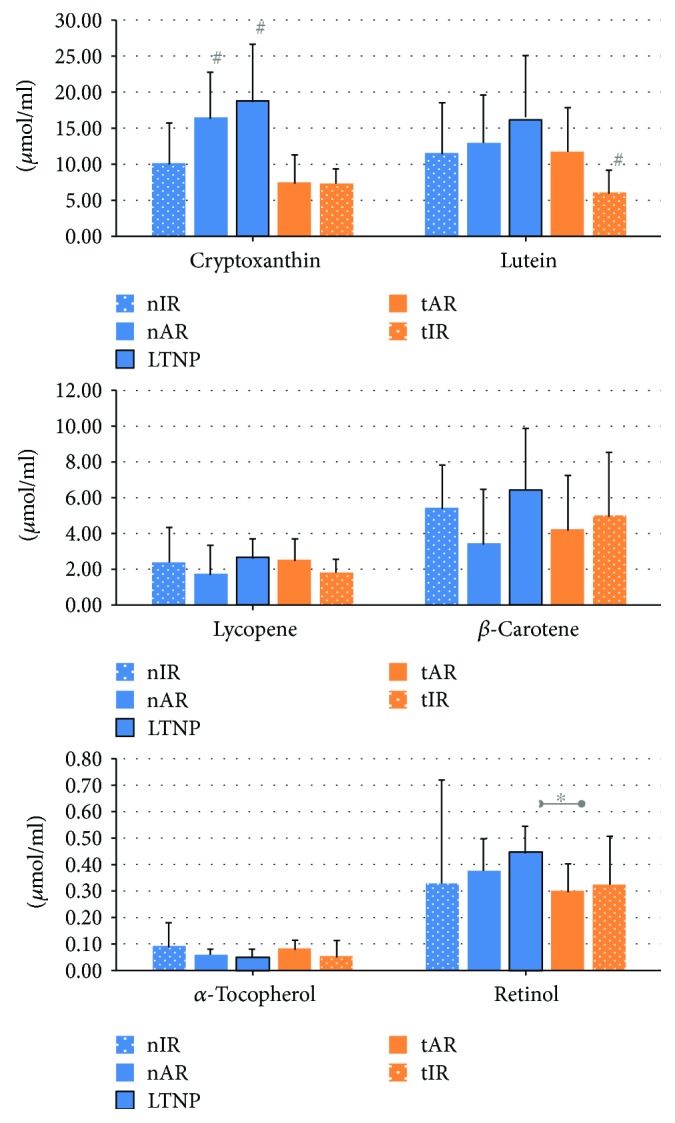
Plasma levels of carotenoids, retinol, and α-tocopherol of the 92 people living with HIV/AIDS, according to the five study groups. LTNP presented higher cryptoxanthin and retinol in relation to cART groups. Statistical tests: gamma distribution. ∗
p < 0.05, comparing the indicated groups; #
p < 0.05, difference among all the other groups.